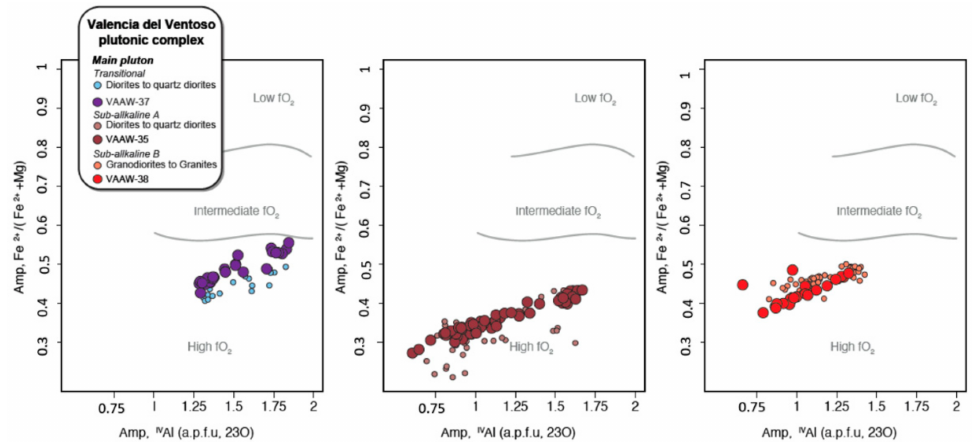
Figure 7. Fe 2+ /(Fe 2+ + Mg) versus Al IV occupancy in amphibole from intermediate and border facies rocks from the Valencia del Ventoso main pluton with oxygen fugacity fields as proposed by Anderson and Smith